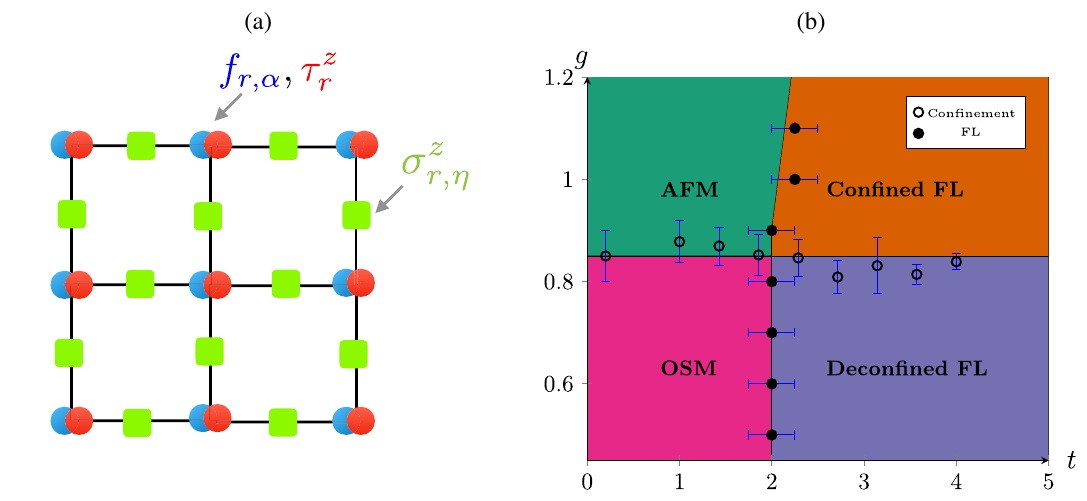
(blue circle) and r; α (green square) is defined on the lattice bonds. (b) Global r; η